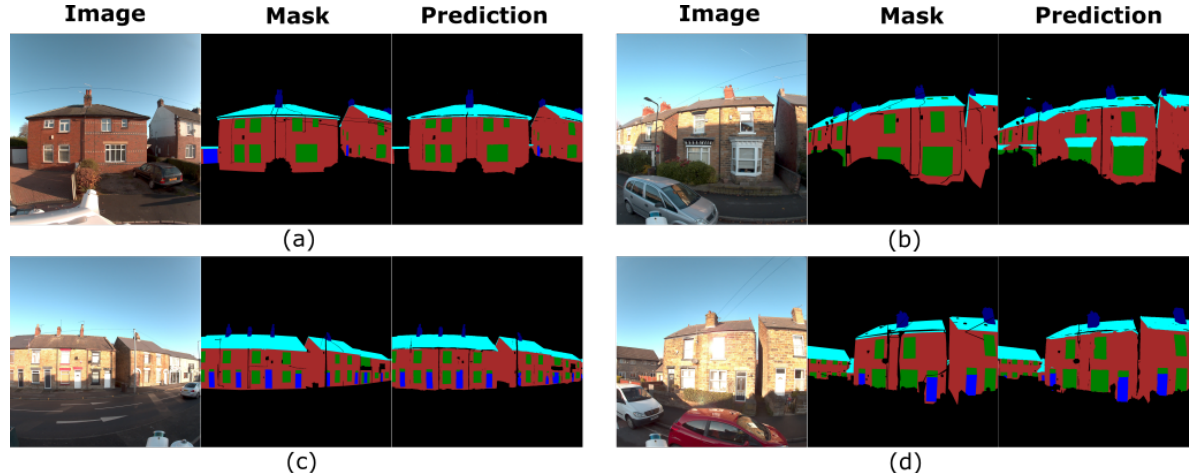
Figure 4. Demonstrations of qualitative semantic segmentation results on the Sheffield dataset. Building types include detached, terraced and semi-detached houses. ( a ) Semi-detached house, individual homes are recognised by the bush partition wall; ( b ) Detached house, a building without obvious signs of individual homes; ( c ) Terraced house, structurally integrated homes, individuals can be inferred by multiple doors; ( d ) Semi-detached house, individual homes are recognised by isolated